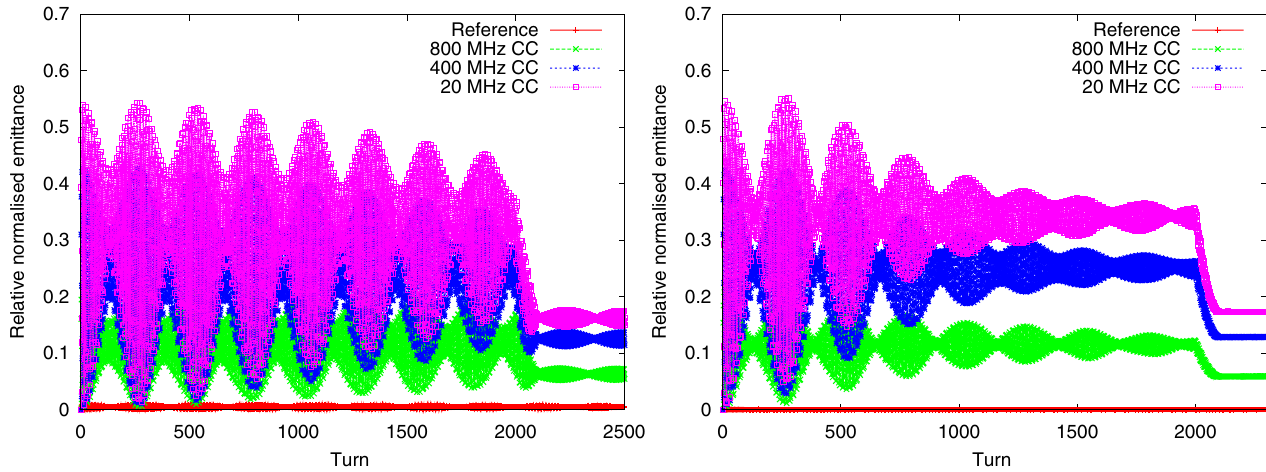
FIG. 19. (Color) Relative horizontal emittance growth due to the crab cavity ramping with different frequency crab cavities (20, 400, and 800 MHz), without (left) and with (right) Landau octupoles, with 1 turn ramping speed. The lower the frequency is, the larger the emittance growth will